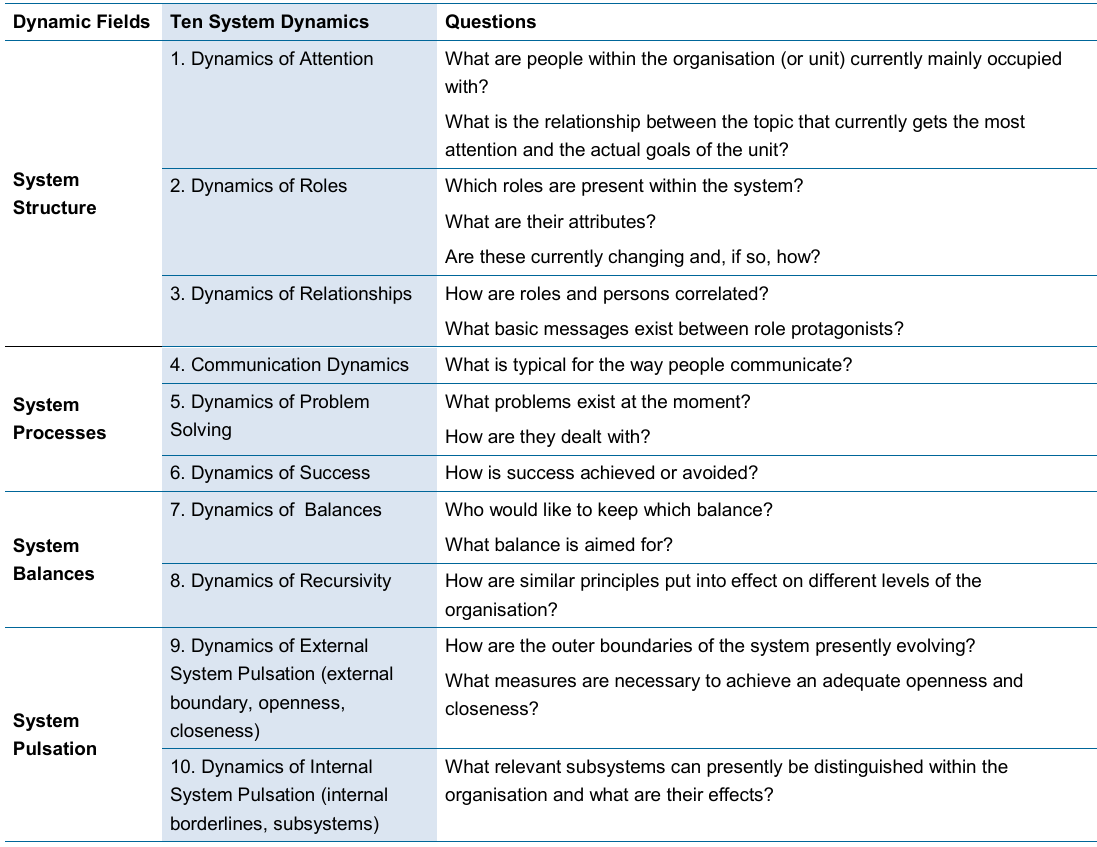
Table 3: Model of Ten System Dynamics (Mohr